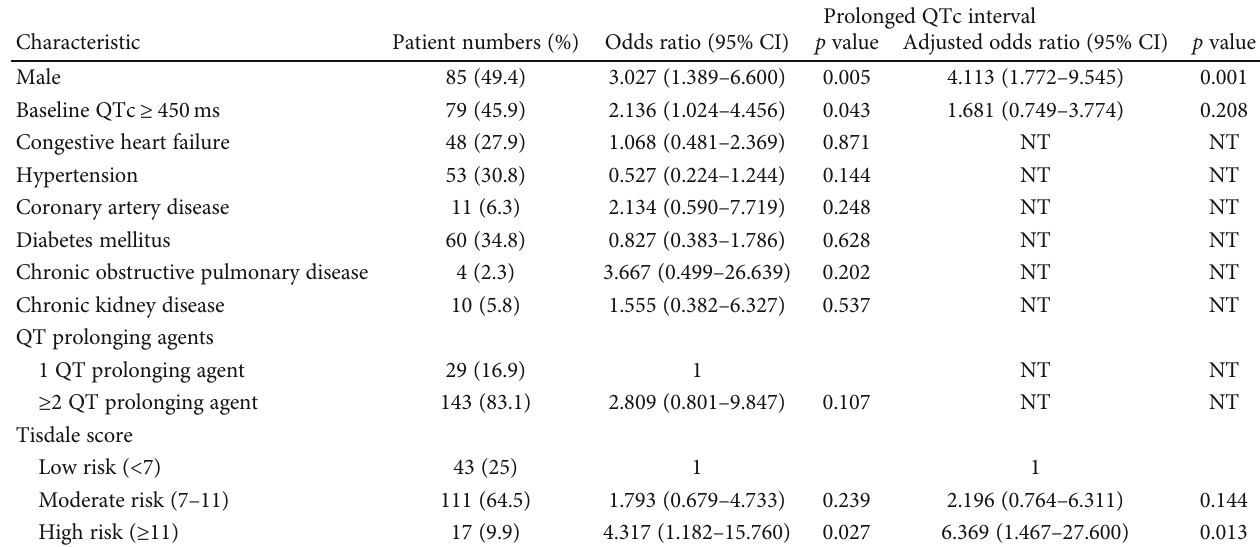
Table 4: Prolonged QTc interval (corrected QT interval) risk